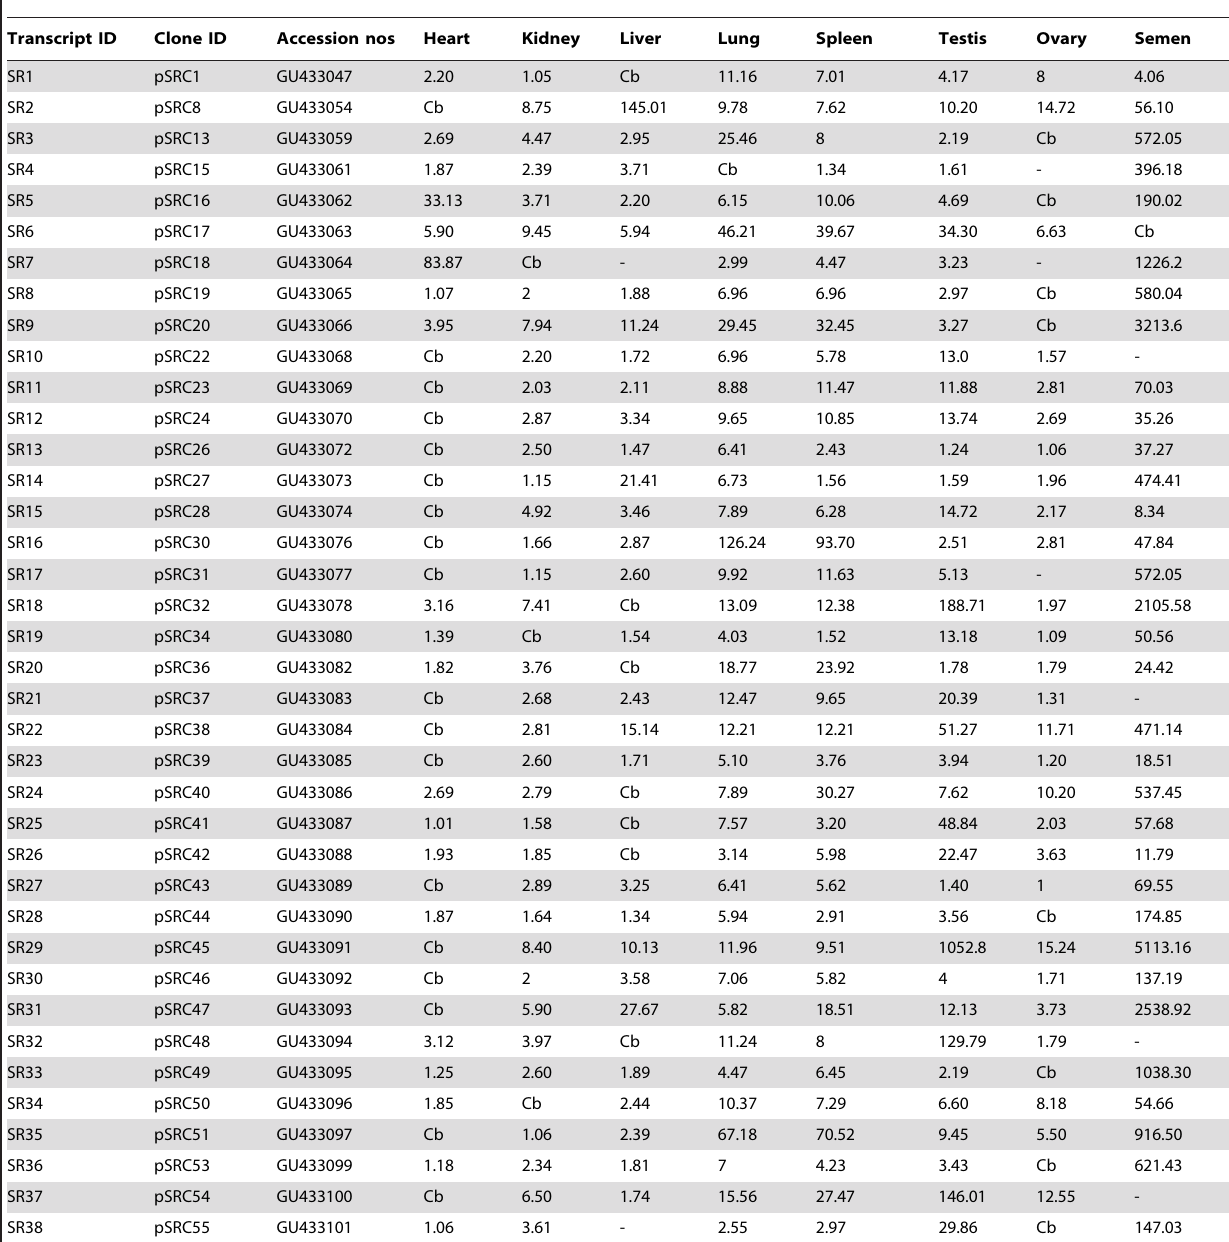
Table 1. Relative expression for all the TGG tagged transcripts uncovered from somatic tissues and gonads of water buffalo Bubalus